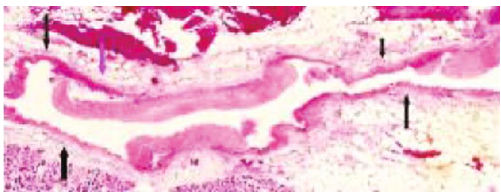
Figure 2: Segmental arterial mediolysis injurious phase. Longitudinal segment of pancreatic artery with arrows pointing to segmentally formed arterial gaps. The magenta arrow points to a beginning dissection that will ultimately either detach the muscular island to enlarge the gap or create a dissecting aneurysm. Hematoxylin & eosin × 10 (adapted with permission from Laboratory Investigation 15(1) copyright 1976, Nature Publishing Group).